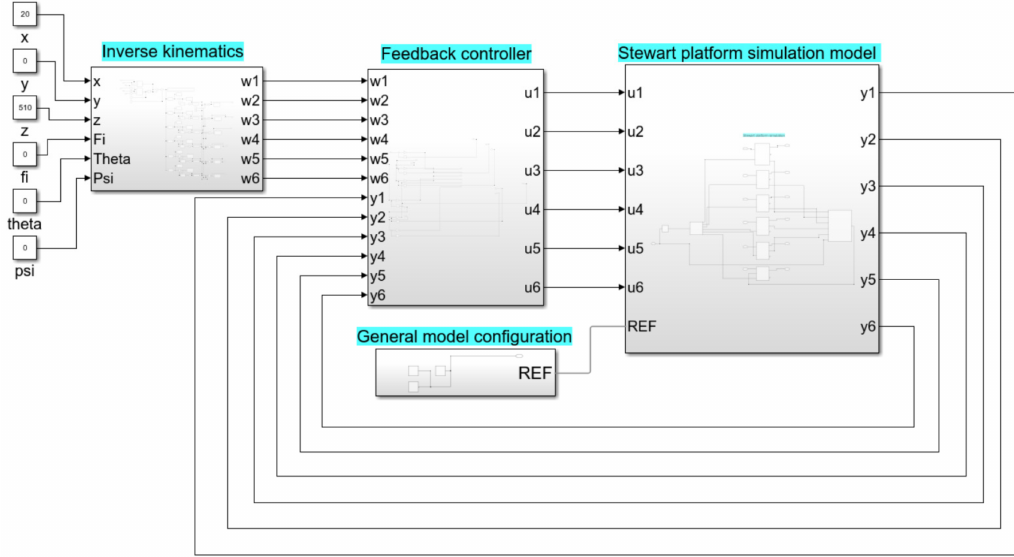
Figure 6. Simulink block diagram of the Stewart platform for MiL